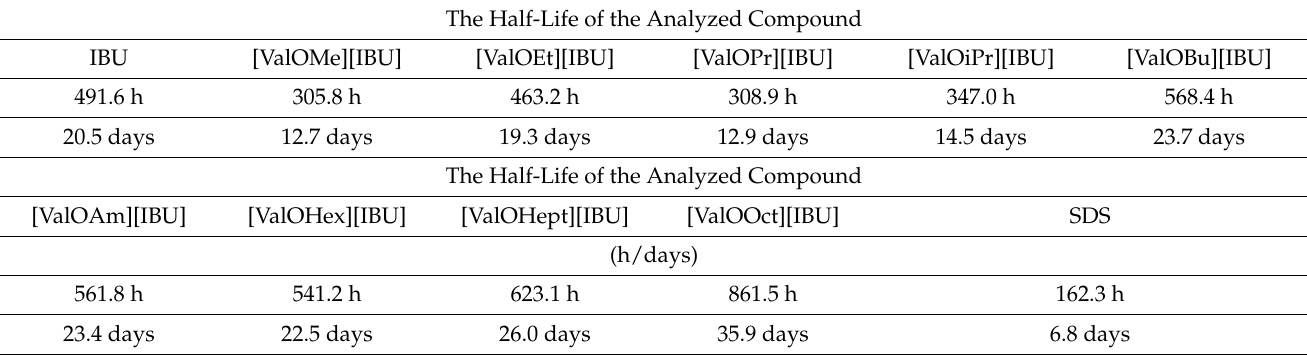
Table 1. Half-life of ibuprofen and L-valine alkyl esters ibuprofenate by bacterial cultures. The Half-Life of the Analyzed